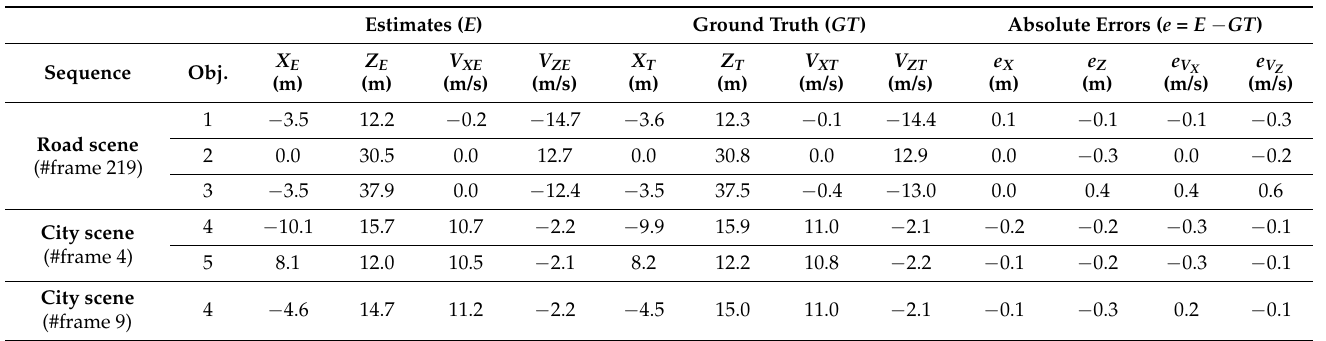
Table 2. Position and absolute velocity of objects in Figure 5 and their estimate errors. Estimates ( E ) Ground Truth ( GT ) Absolute Errors ( e = E − GT